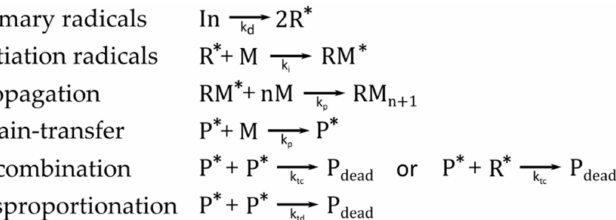
Figure 3. Mechanism of free-radical polymerizations, comprising the decomposition of the initiator, the formation of the initiation radicals, and the propagation, chain-transfer and terminating reactions.